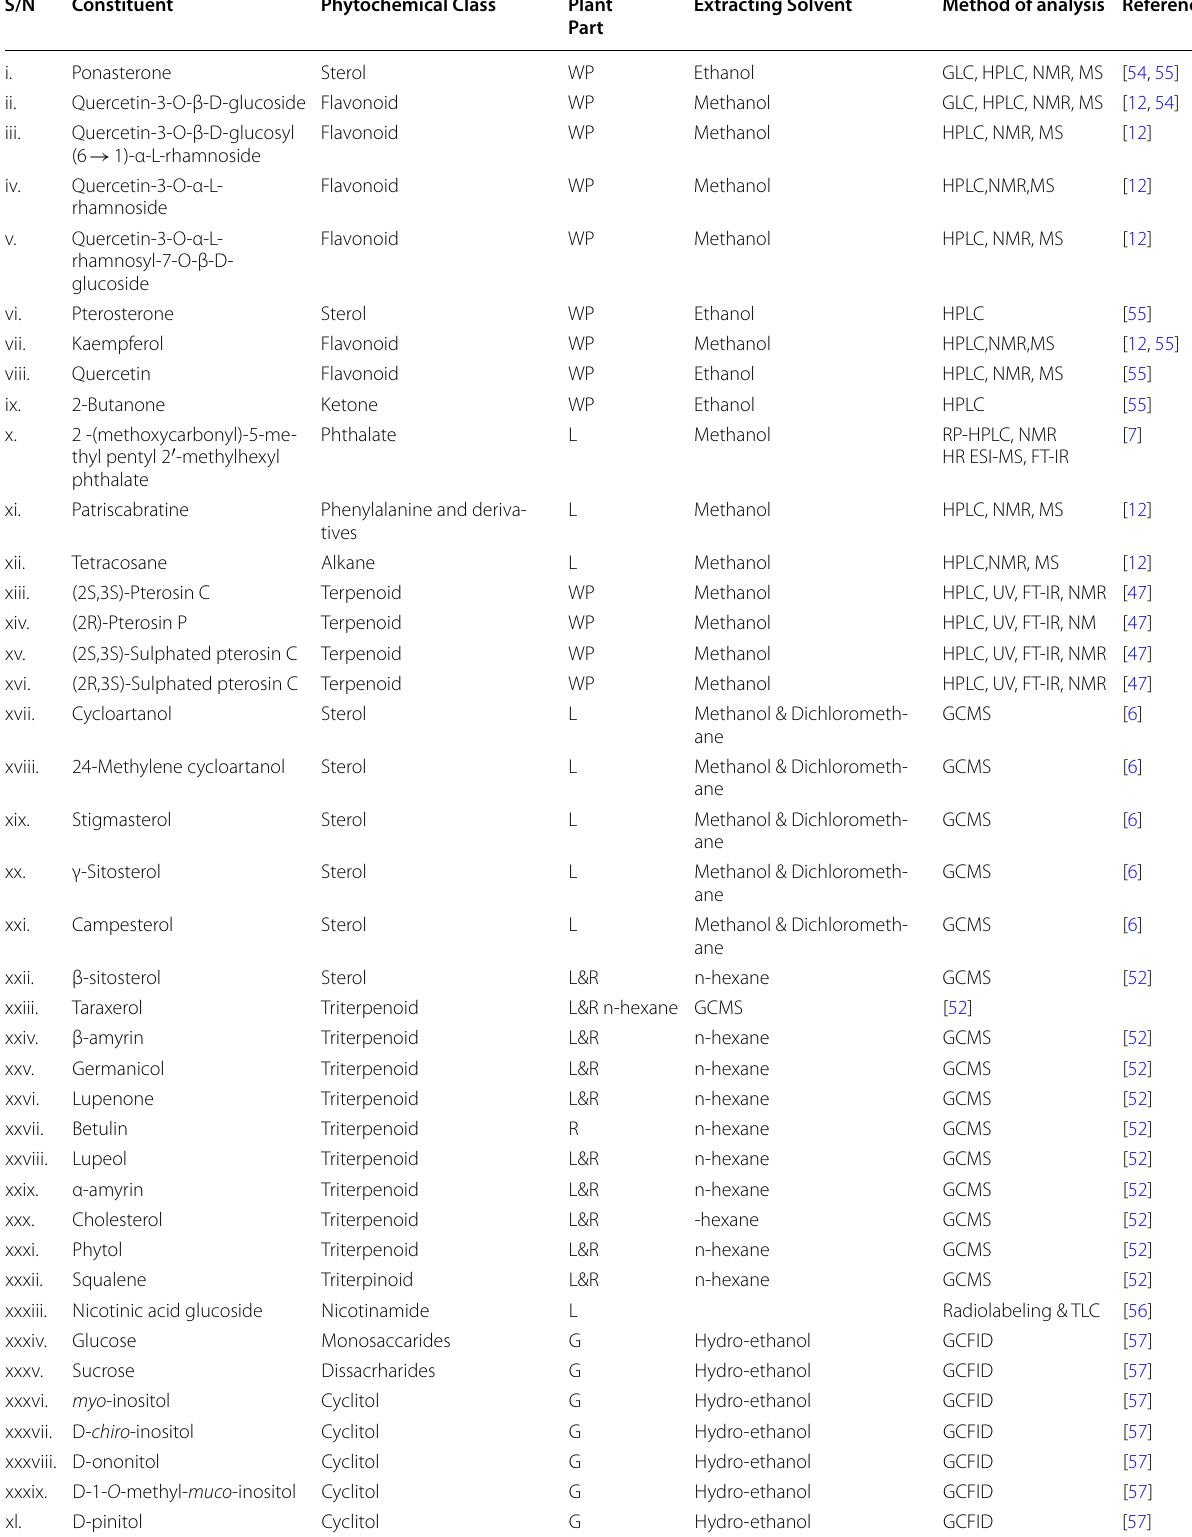
Table 3 Isolated and identified compounds in Acrostichum aureum S/N Constituent Phytochemical Class Plant